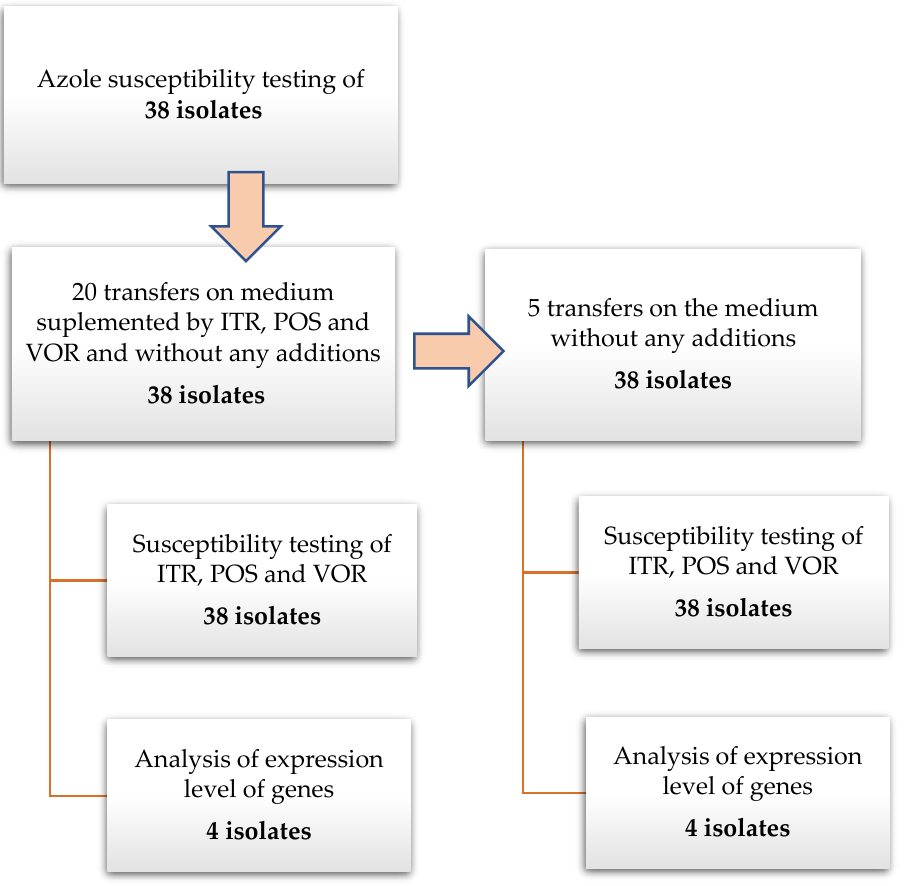
Figure 1. Schema of the experimental protocol.